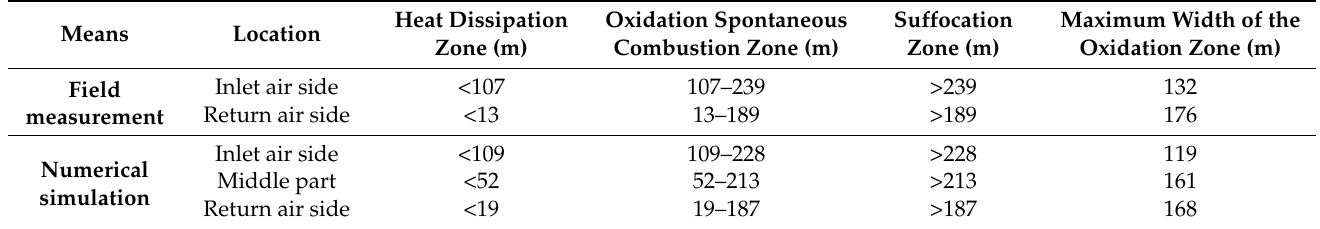
Table 3. The comparison of three zones in the goaf of the 8824 isolated-island working